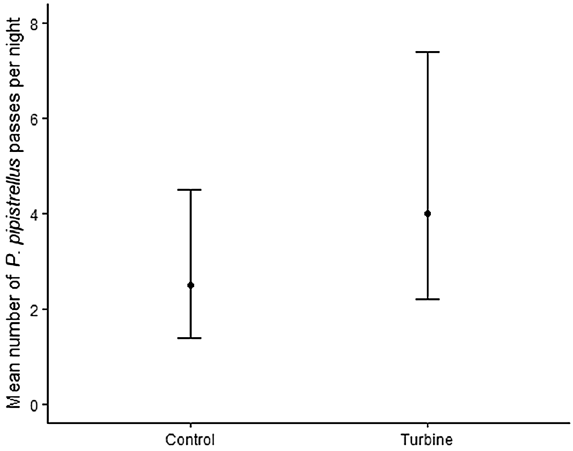
Figure 2. Predicted mean passes per night with 95% confidence intervals at the turbine and control locations across 23 wind farm sites for P. pipistrellus